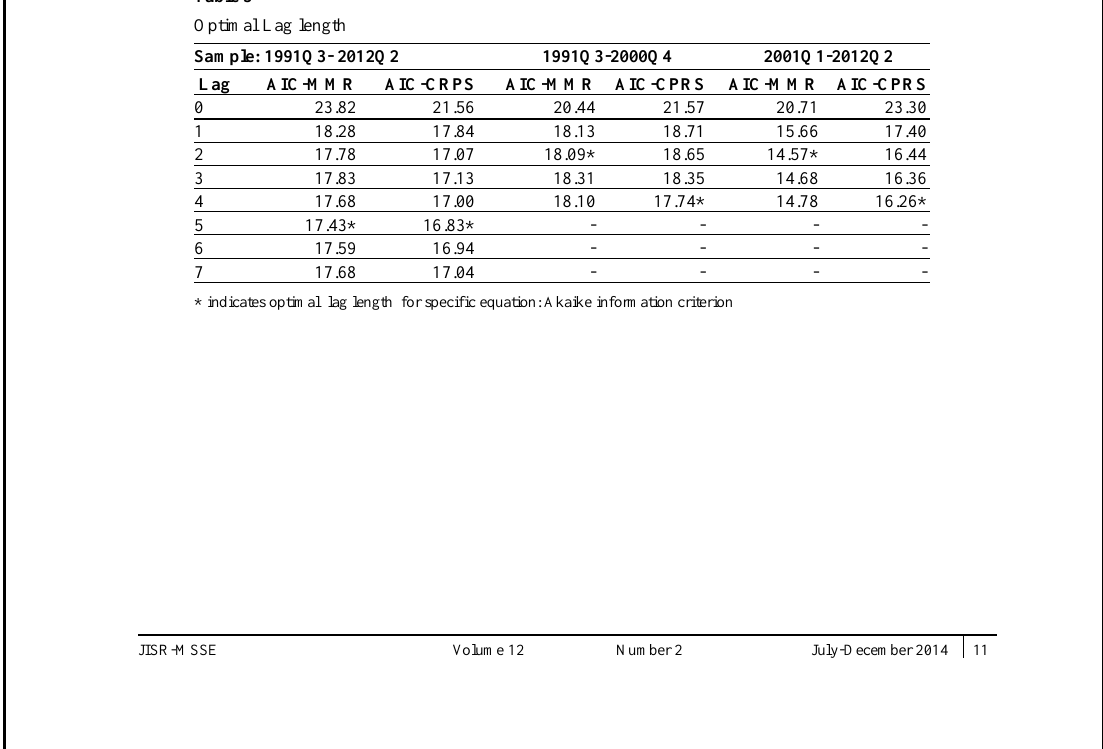
Critical value at 5% and 10% level of significance is: -2.896779 and -2.585626 respectively